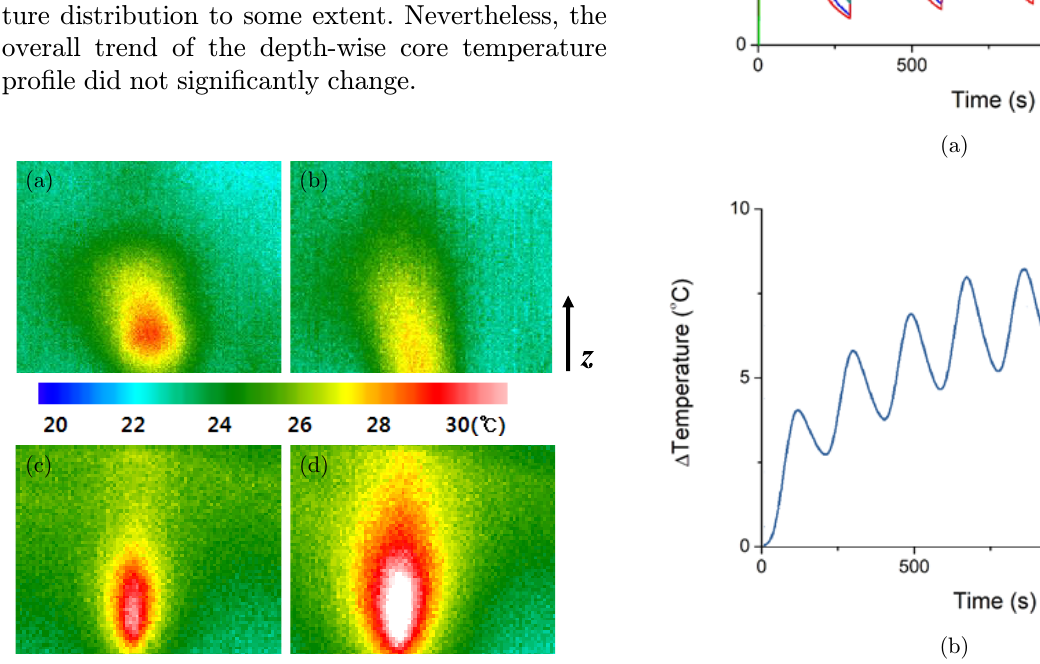
Fig. 8. (a) Temperature variations in tissue phantoms heated using the laser moxibustion device at pulse level 7 and (b) Temperature variation of the tissue phantom heated by burning commercial moxa.